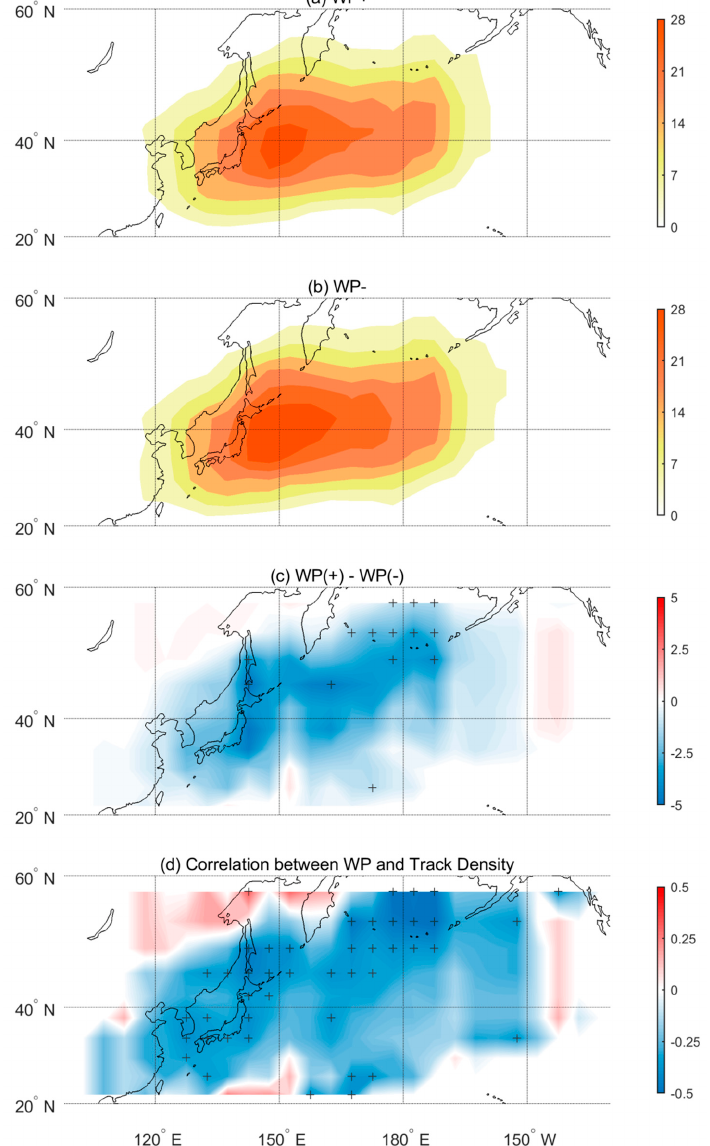
Figure 4. ( a , b ) Composite of the ETC track density in positive and negative phases of WP over the Northwest Pacific in wintertime from 1979 to 2018, Unit: cyclones per winter per grid. ( c ) The difference in ETC density between the positive and negative phases of WP. ( d ) Correlations between the WP index and ETC track density. Grids with values statistically significant at the 95% level are indicated by the symbol “+”.